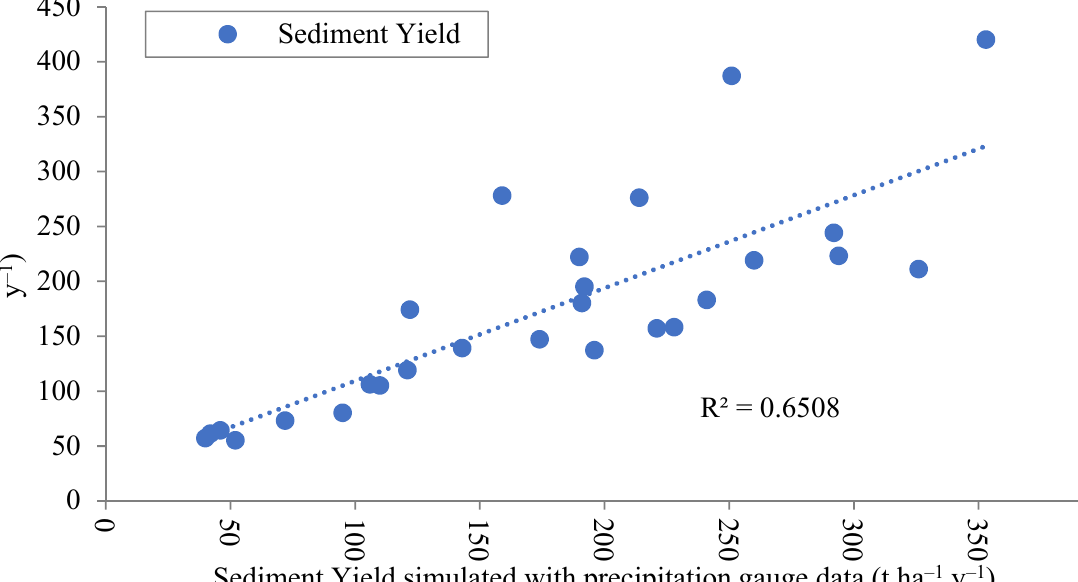
Figure 11. Relationship between sediment yields simulated with observed and GPCC precipitation datasets .